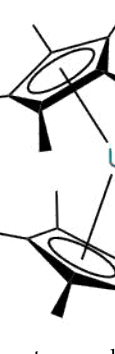
Figure 6. The structure and stereochemistry of U(C 5 Me 5 ) 3